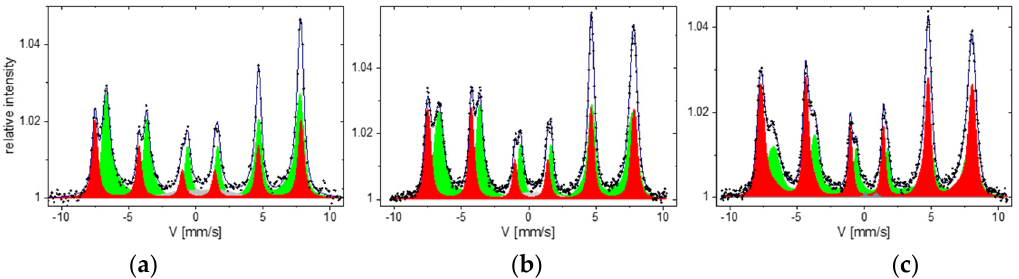
Figure 3. CEMS spectra of a 100 Å magnetite film measured in situ ( a ) and ex situ, after one and six months after exposure to the atmosphere ( b , c ), respectively.